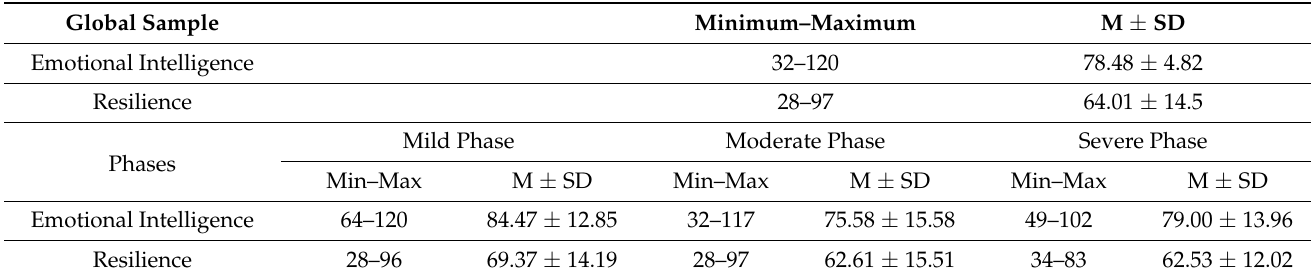
Table 3. Mean scores of resilience, emotional intelligence, and occupational performance, global sample and according to phase of